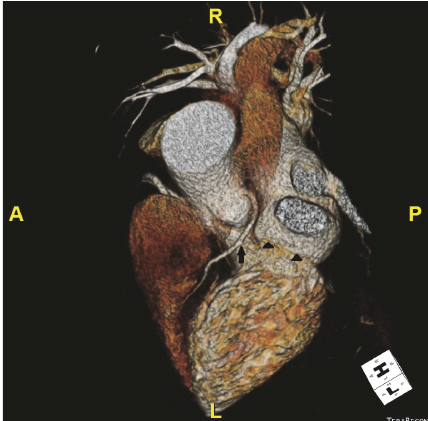
Figure 4: Top view three-dimensional computed tomography scan showing single left anterior descending artery (arrow) and absence of LCX in the atrioventricular groove (arrow heads).